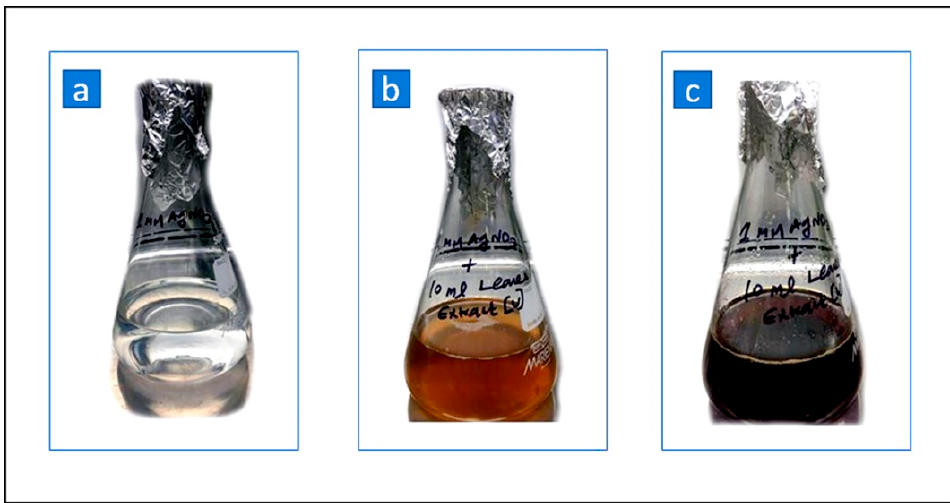
Figure 1. Ethyl acetate extract of UD leaves mediated the preparation of AgNPs. ( a ) Silver nitrate solution; ( b ) mixture of plant extract and silver nitrate; ( c ) formation of AgNPs.